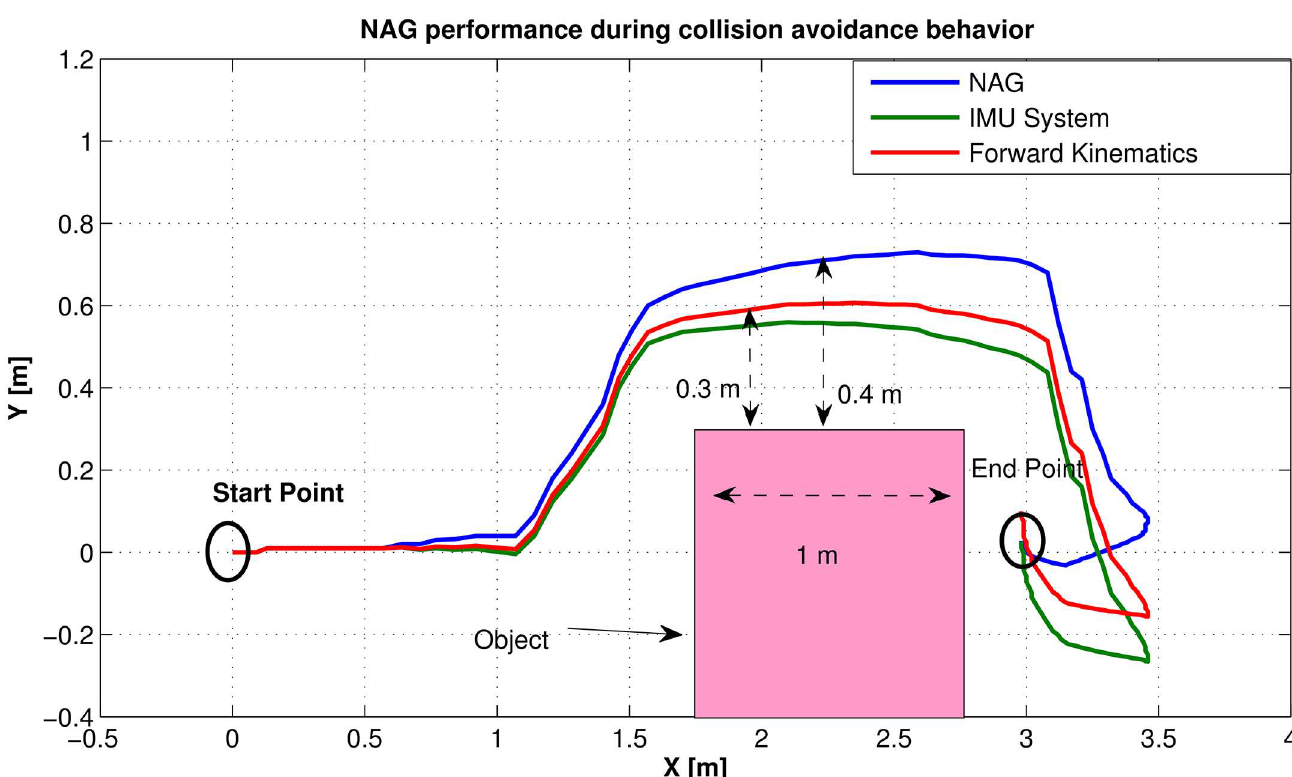
Fig 19. NAG performance during collision avoidance